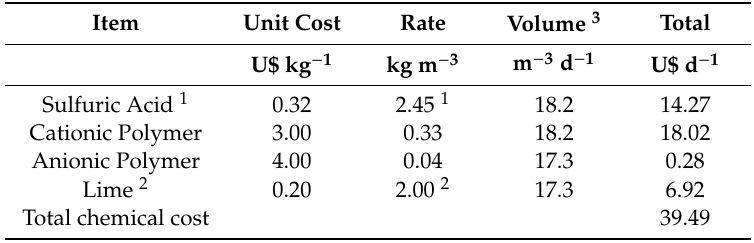
Table 5. Costs of chemicals for treating dairy manure slurry produced by 300 lactating cows (20.4 m 3 ) using the Quick Wash process.